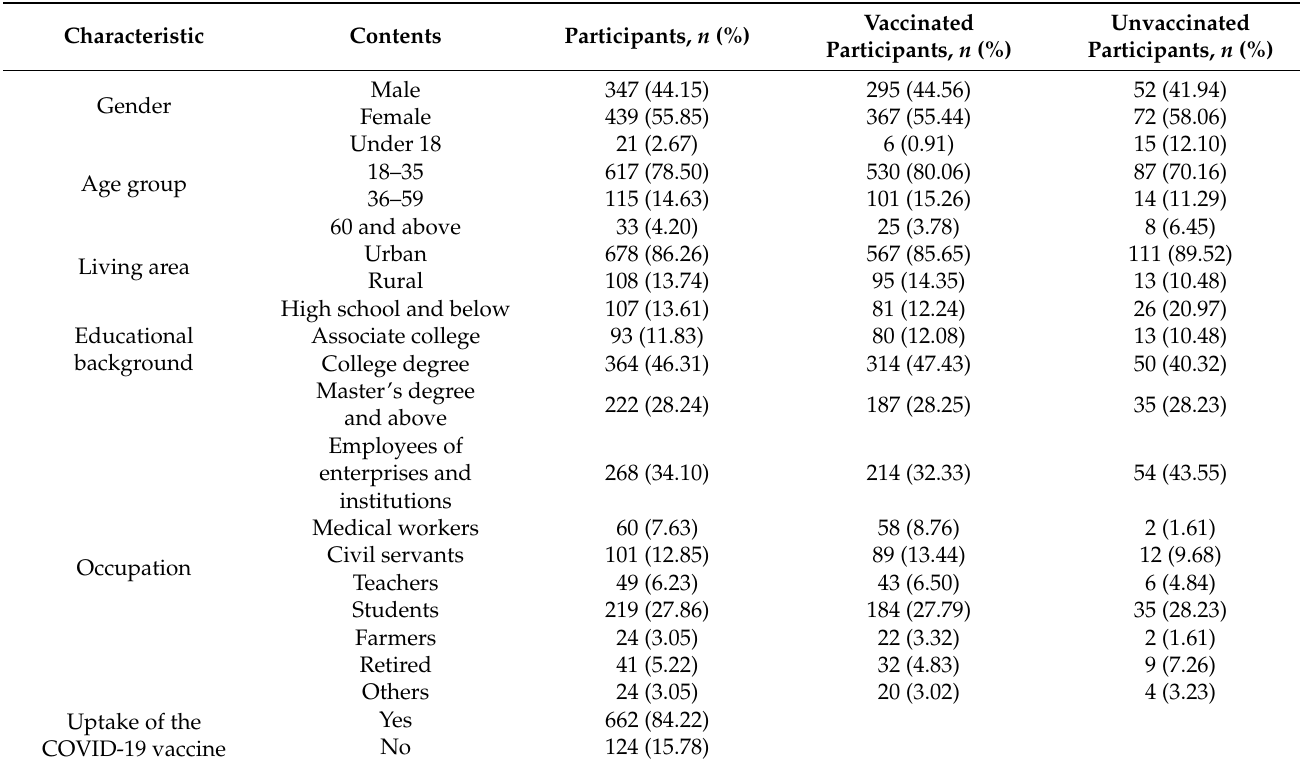
Table 1. Sociodemographic characteristics of survey participants ( n =